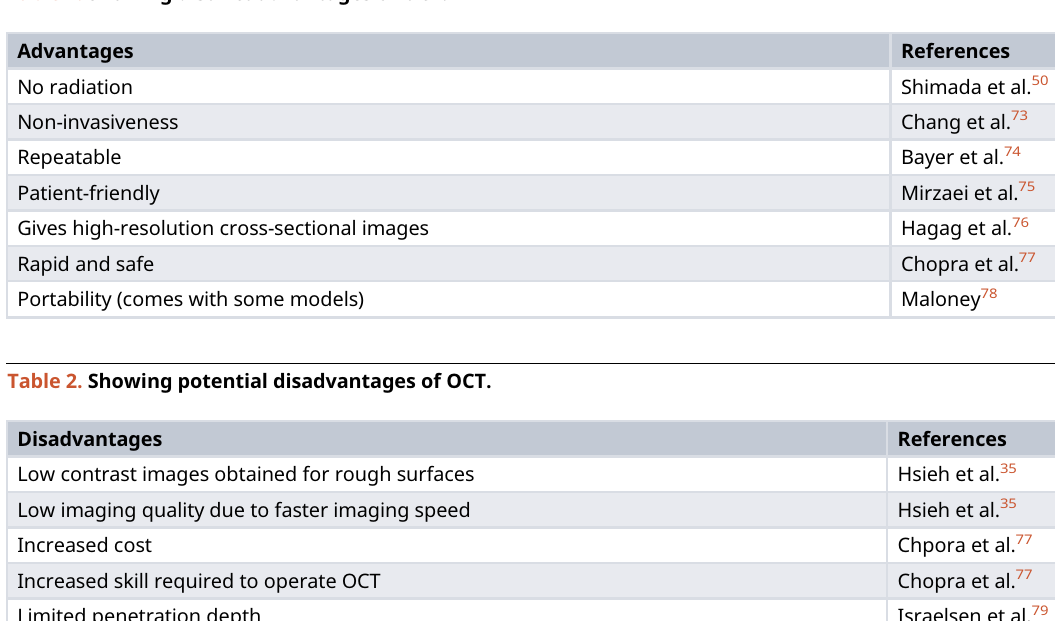
Table 1. Showing distinct advantages of OCT.